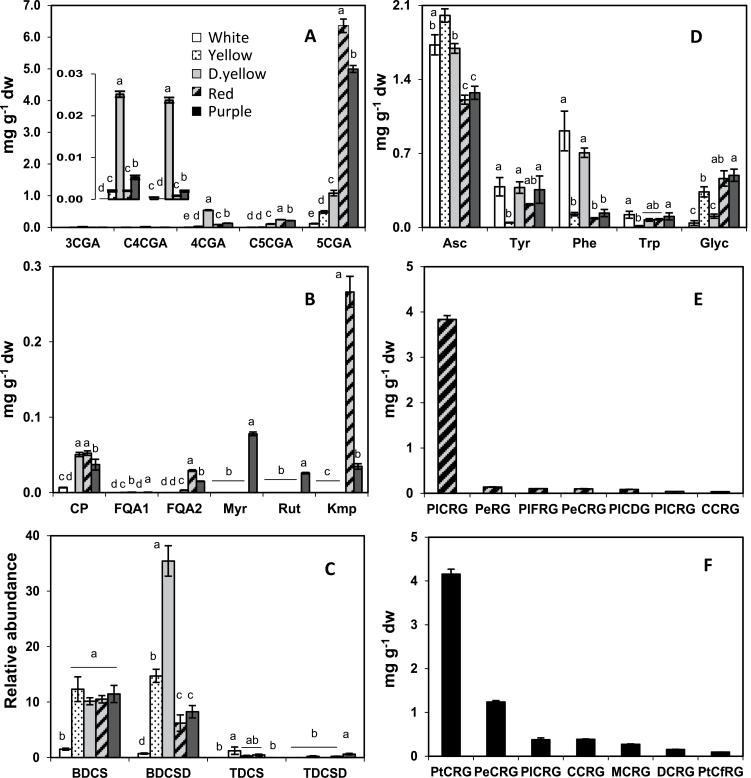
Individual metabolites measured by LC/MS in the five genotypes. 5CGA and CGA isomers, with 3CGA and C4CGA in the inset (A); caffeoyl and feruloyl derivatives and flavonols (B); polyamines (C); ascorbic acid, aromatic amino acids, and glycoalkaloids (D). (E, F) Individual anthocyanins in red (E) and purple (F) potatoes. The data represents the means±SEM of three biological replicates. Values with the same letter are not significantly different (P<0.05). The key for all panels is shown in (A). Abbreviations are listed in Supplementary Tables S1 and S2.